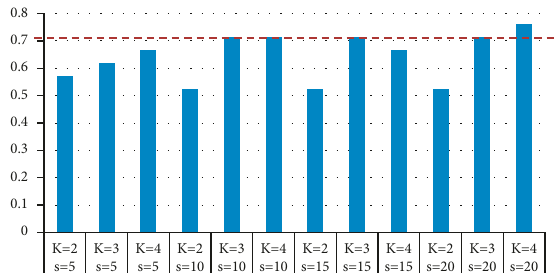
Figure 11: Sensitivity of CBCD on BAC with a threshold 0.005.